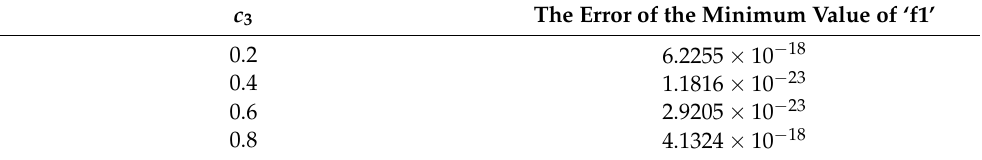
Table 2. The sensitivity analysis of c 3